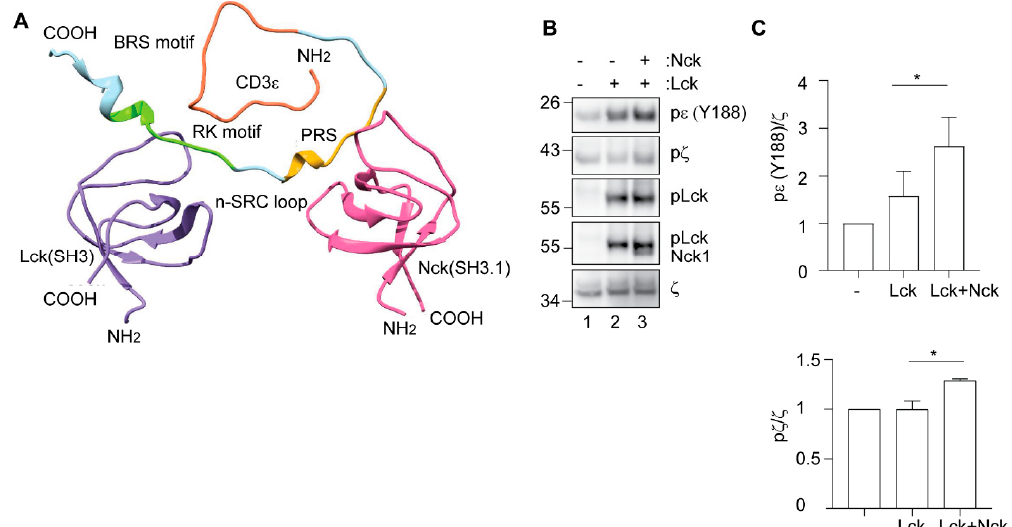
Figure 4. Simultaneous binding of Nck and Lck to the TCR enhances CD3 phosphorylation. ( A ) Backbone representation of the modeled complex formed by Lck(SH3) and Nck(SH3.1) with the CD3 ε cytoplasmic tail. Purple, Lck(SH3); pink, Nck(SH3.1); multicolor, CD3 ε . CD3 ε motifs are depicted. Orange, Basic Rich Sequence, BRS; yellow, Proline-Rich Sequence, PRS; green, Receptor Kinase, RK motif. ( B ) 31–13.scTCR β cells are TCR β -deficient Jurkat cells expressing an scTCR